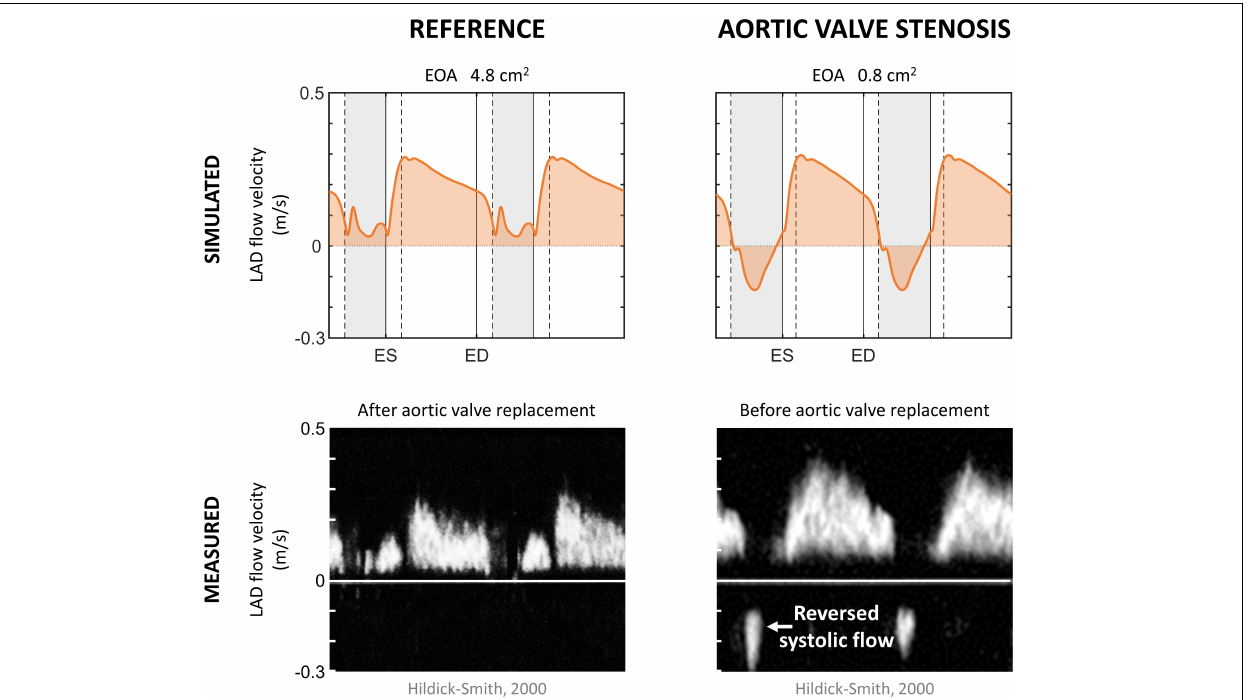
FIGURE 5 | Aortic valve stenosis. Simulated left anterior descending (LAD) coronary artery flow velocity in the reference and aortic valve stenosis case, together with measured LAD flow velocity in patients 6 months after and before aortic valve replacement (Hildick-Smith and Shapiro, 2000). Vertical gray areas indicate left ventricular ejection and vertical dashed/solid lines indicate opening/closing of left ventricular cardiac valves. ED, end-diastole; EOA, effective orifice area; ES,